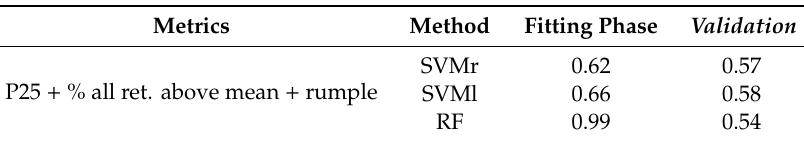
Table 7. Fuel type classification using ALS data.